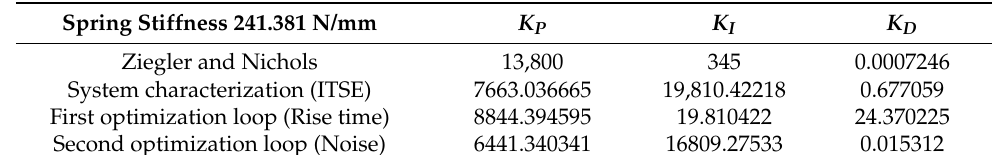
Table 4. PID parameters for Ziegler and Nichols, and the three optimization loops for the spring load of a spring stiffness of 241.381 N/mm.